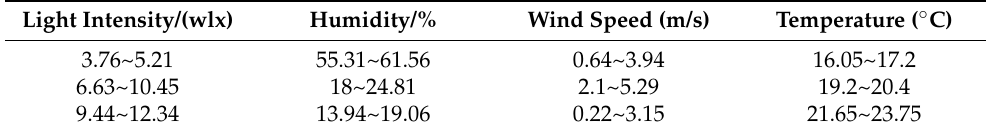
Table 4. Environmental parameters of the field